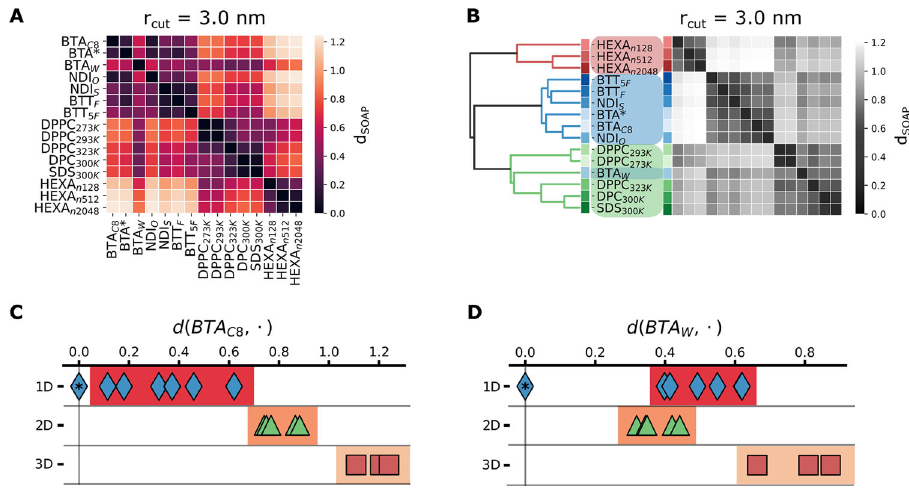
Fig. 7 Similarity classi fi cation of soft, dynamic supramolecular materials. A Distance d SOAP matrix (as reported in Fig. 6B) computed from the SOAP simulation -averages using a cutoff rcut = 3.0 nm. B Hierarchical clustering plot and consequent reshuf fl ing of the d SOAP matrix rows and columns, showing grouping of the system according to SOAP similarity. C assembly (theoretical) dimensionality as a function of the d SOAP distance from the reference BTA C 8 . ( D ) same as ( C ) with BTA W as